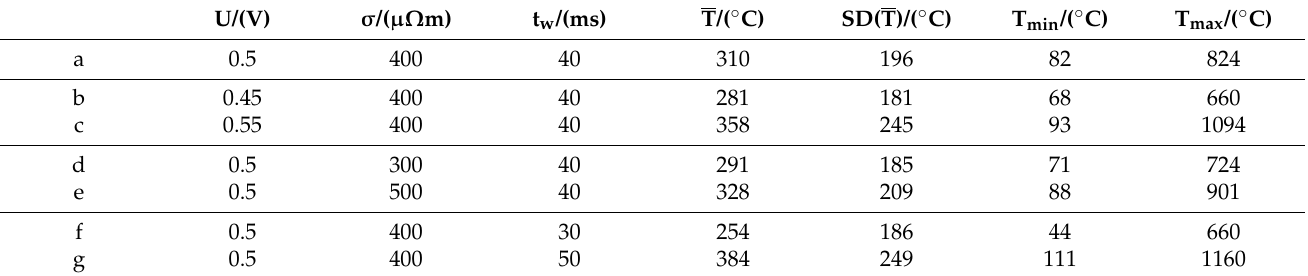
Table 6. simulation parameters and results of parameter